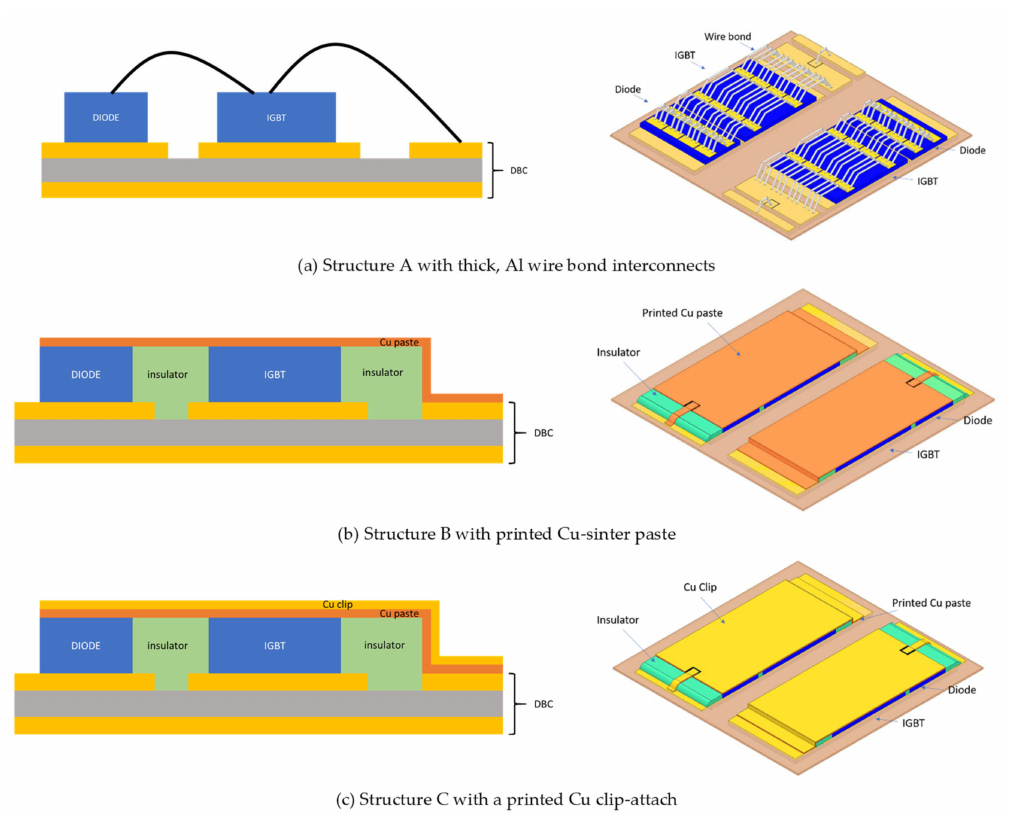
Figure 1. Top-side interconnect structures: ( a ) structure A with Al thick wire bond ( b ) structure B with printed Cu sinter-paste, ( c ) structure C with printed Cu clip-attach. ( b , c ) are two variations of “sinterconnect”